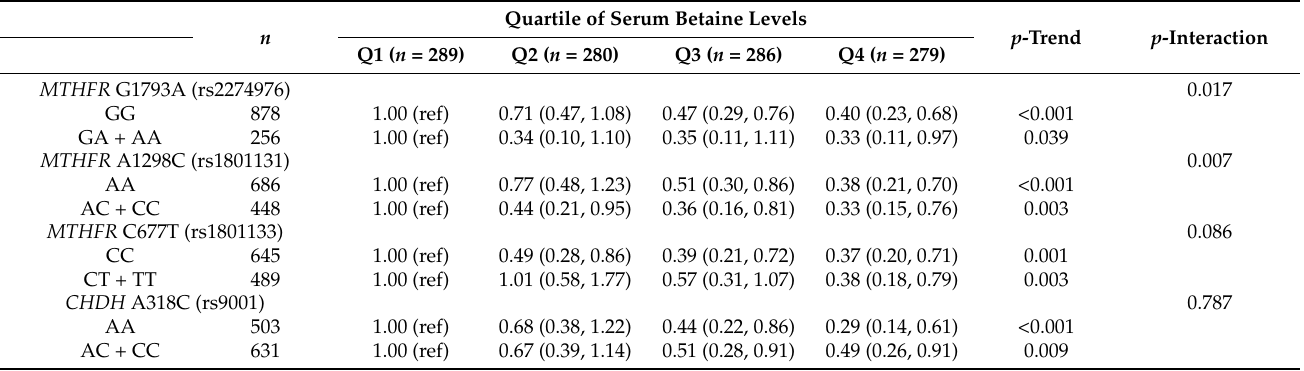
Table 4. Adjusted hazard ratios (HRs) and 95% confidence intervals (CIs) of type 2 diabetes